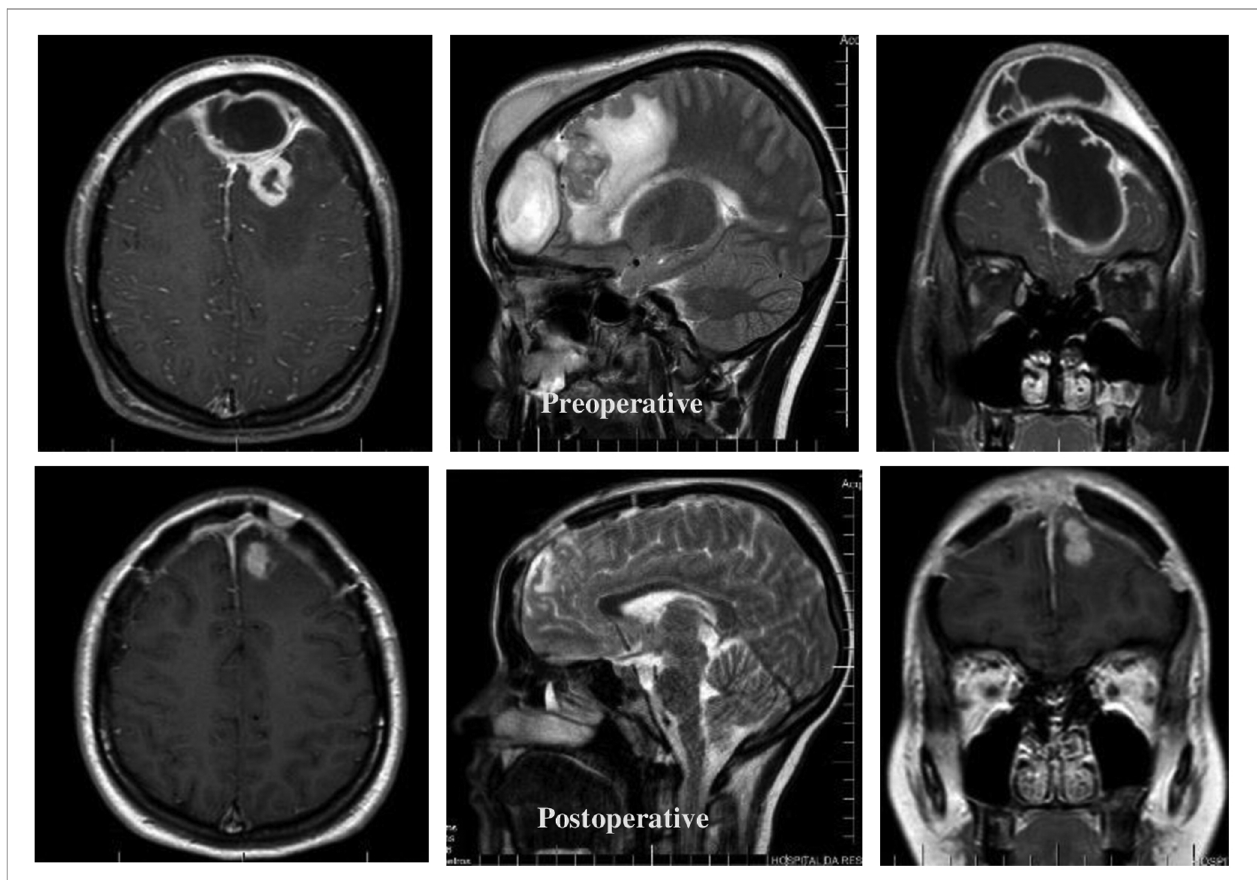
FIGURE 4 | Comparative study between MRI in axial, sagittal and coronal sections before and after the surgical